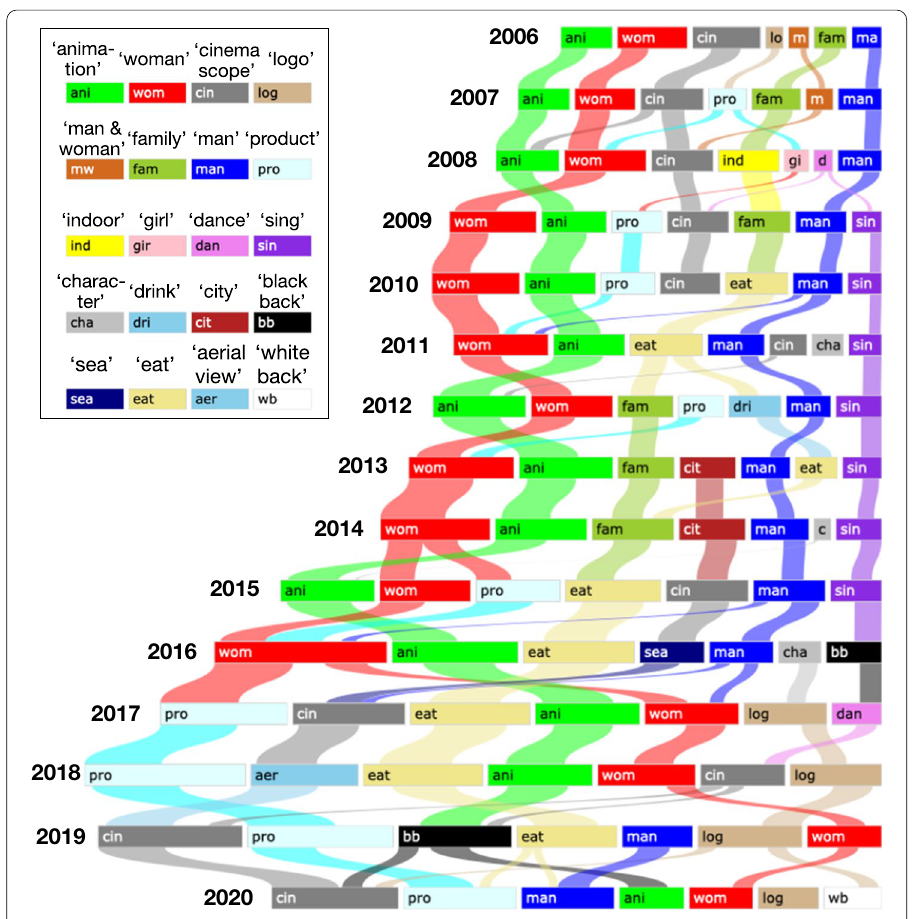
Fig. 3 Sankey diagram showing the flow of nodes between communities. Each colour denotes the community with each representative node, as shown in the